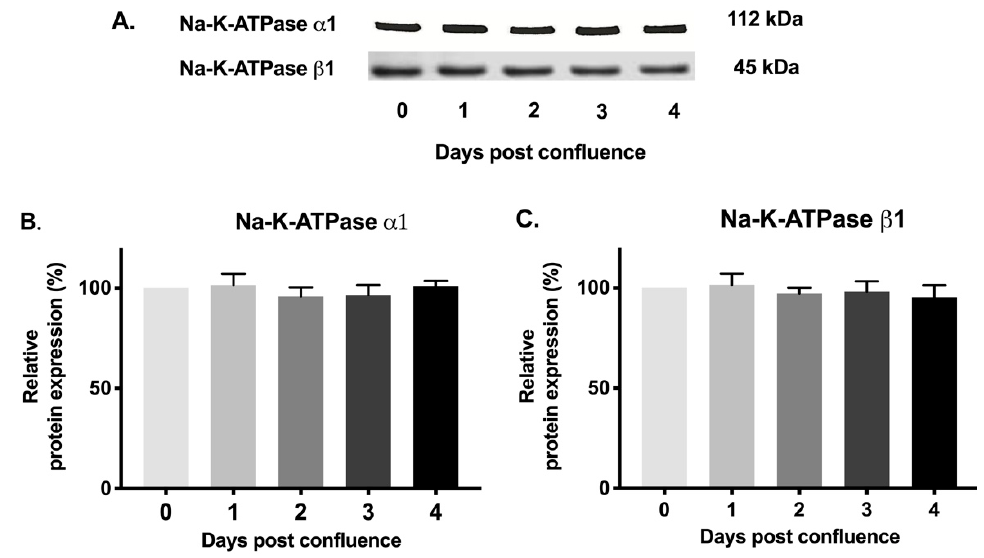
Figure7. WesternblotanalysisofIEC-18cellsinplasmamembranefractions. ( A ).Representativeblotsof Na-K-ATPase α 1 and Na-K-ATPase β 1. Densitometric quantitation of Western blots. ( B ). Na-K-ATPase α 1 and ( C ). Na-K-ATPase β 1. Equal amount of proteins were loaded. Values are relative to 0-day and represented as mean ± SEM, n =